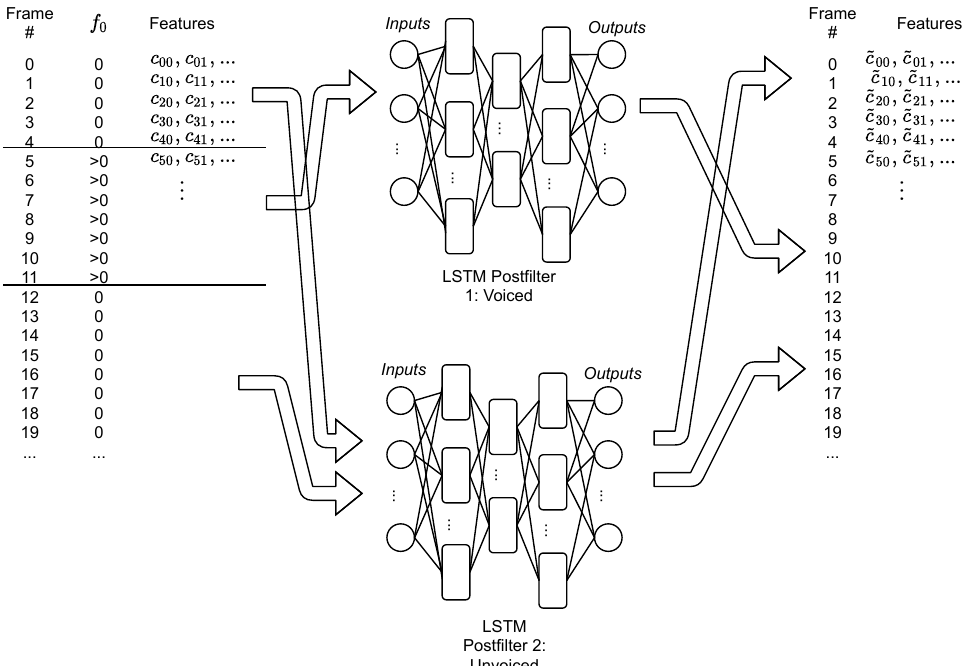
Figure 3. Procedure followed in the test set. Each frame is labeled with a number, and according to the value of f 0 is enhanced by one of the postfilters. After the enhancing, the frames are concatenated again and the speech is re-synthesized.